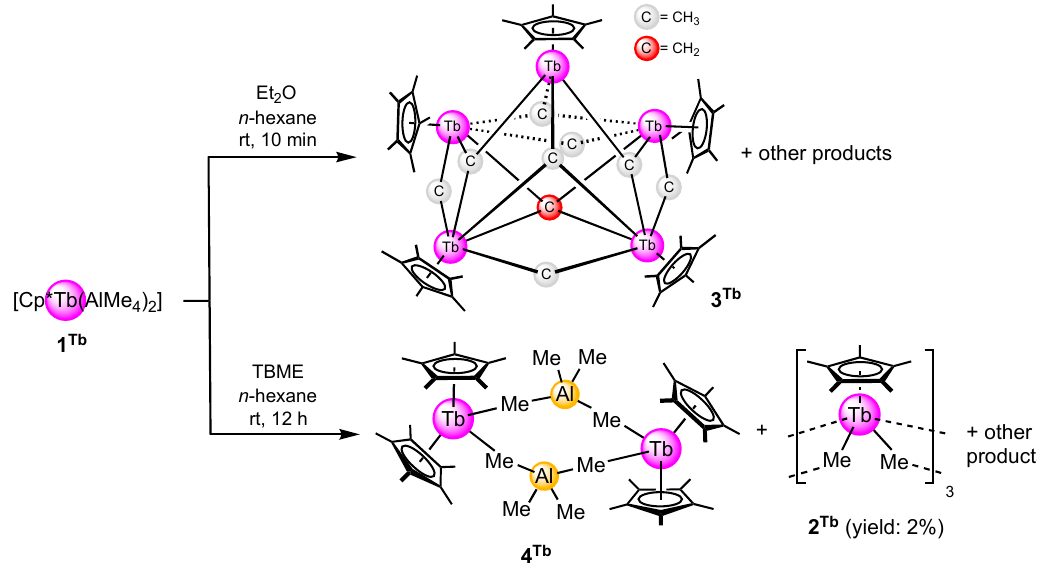
Figure 4. Ternary plot of the microstructures of the poly-1,3-butadienes (a) and polyisoprenes (b) obtained from of [Cp*LnMe 2 ] 3 ( 2 Ln ). Polymers produced applying cocatalyst A are represented by circles, those produced with cocatalyst B by squares. The metal centers of the precatalyst are color-coded as follows: orange (Dy), brown (Ho), cyan (Y), and grey (Lu). Data for the reactions applying the Y and Lu analogue precatalysts are shown for comparison